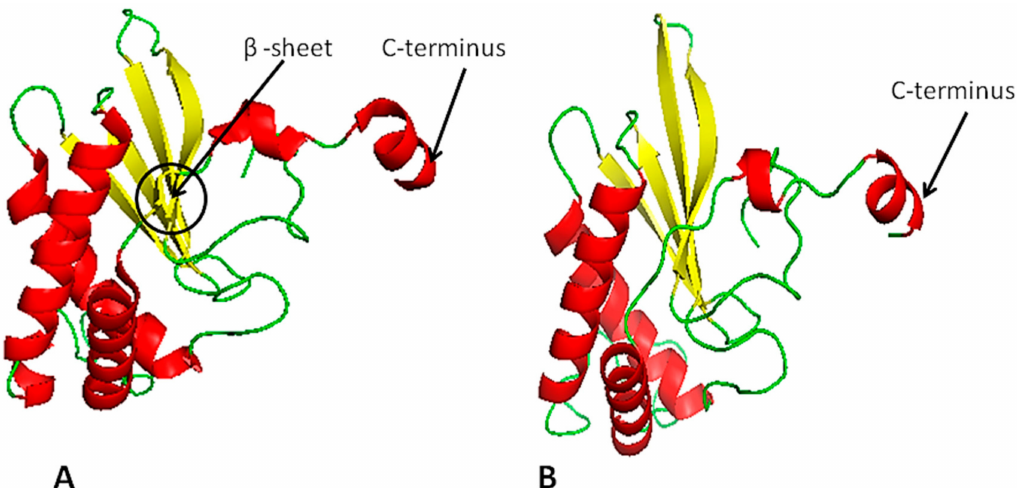
Figure 4. ( A ) LuxS homology model and ( B ) predicted 3D-structural model of the LuxS protein. Red indicates alpha helices, yellow indicates sheets, and green indicates loops. The difference between template and predicted model is found. The template contains one extra beta sheet shown within the black circle (about two residues long) and has long alpha helices. The predicted model at C-terminus alpha helix has short, long loops and one residue found is the loop at C-terminus, while the template does not contain any loop residue at the